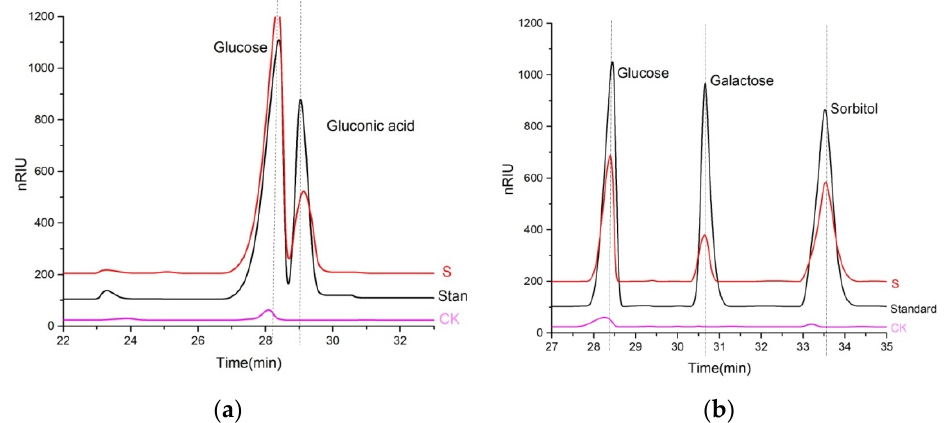
Figure 4. Identification of n Ta AA9A reaction products using HPLC–RID. ( a ) n Ta AA9A reaction products after incubation of 0.5% PASC with Ta AA9A in 10 mM HOAc–NH 4 OAc (pH 5.0) and 1 mM ascorbate at 50 °C for 48 h, followed by hydrolysis with TFA. C1-oxidized products, if present, were hydrolyzed by TFA to yield glucose and gluconic acid. The standard used was a mixture of glucose and gluconic acid; S: n Ta AA9A reaction products hydrolyzed by TFA; CK, the control sam- ple analyzed as above but without n Ta AA9A. ( b ) Ta AA9A reaction products upon incubation of 0.5% PASC with Ta AA9A in 10 mM HOAc–NH 4 OAc (pH 5.0) and 1 mM ascorbate at 50 °C for 48 h, followed by reduction with NaBH 4 and by hydrolysis with TFA. If there were C4-oxidized products, they were reduced by NaBH 4 , followed by hydrolysis with TFA to yield glucose, galactose, and sorbitol. Standard, a mixture of glucose, galactose, and sorbitol; S: n Ta AA9A reaction products re- duced by NaBH 4 , followed by hydrolysis with TFA; CK, the control sample was analyzed as above, except without n Ta AA9A.